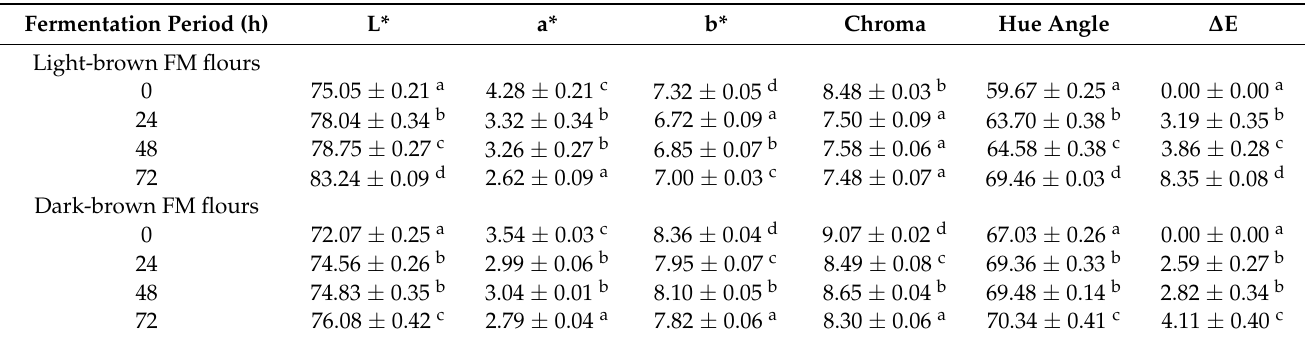
Table 5. Effect of fermentation on the colour properties of spontaneously fermented finger millet